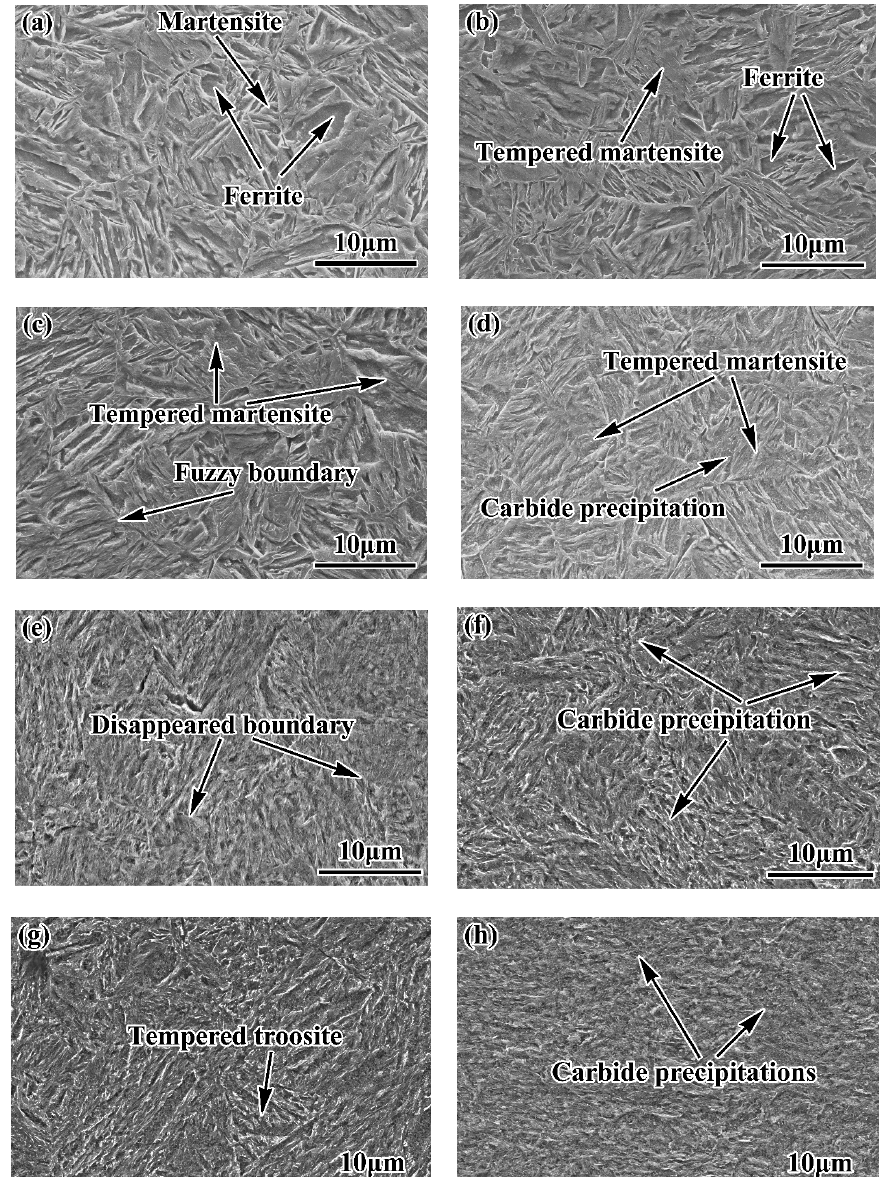
Figure 2. SEM images of the test steels tempered at different temperatures: ( a ) as-quenched; ( b ) 200 °C; ( c ) 240 °C; ( d ) 260 °C; ( e ) 280 °C; ( f ) 300 °C; ( g ) 350 °C; ( h ) 400 °C.